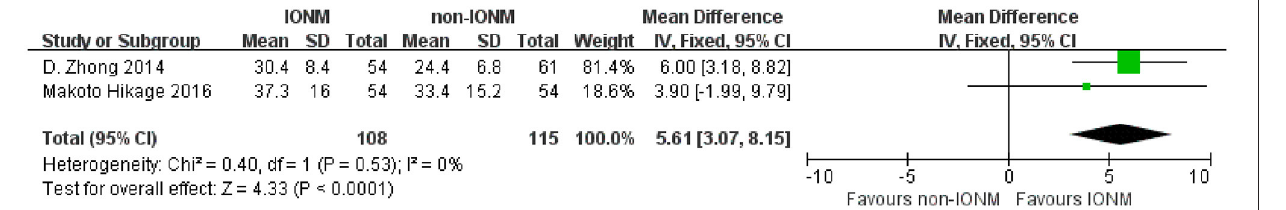
FIGURE 4 | Forest plot of total dissected lymph nodes in the IONM and non-IONM groups.